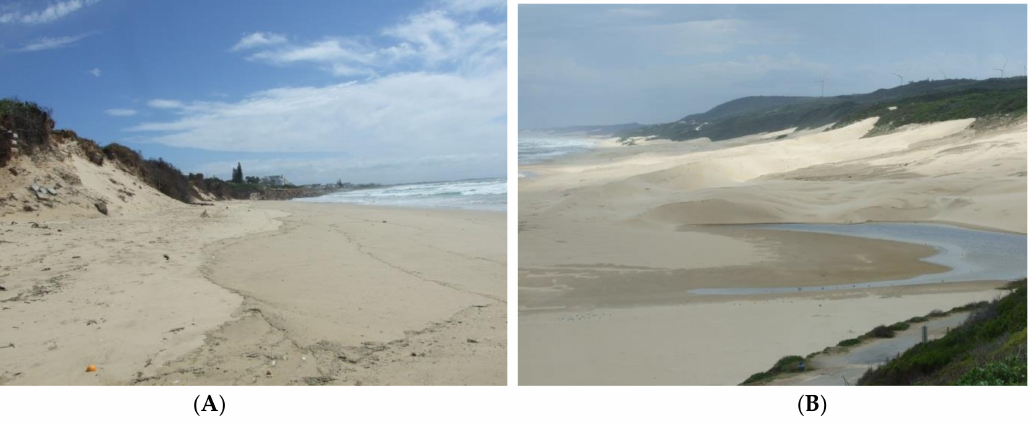
Figure 7. ( A ) St Francis Bay Main Beach that has completely eroded due to inappropriate stabilisation of the dune field that provided the sand supply. Holiday homes are in danger of collapse, as they are positioned just above the eroding dunes shown here (see Lubke 1988). ( B ) Maitland River Mouth where marram grass has never been introduced but any dune pioneers would have little chance of becoming established due to the exposed nature of the undisturbed dunes and the high wind velocities achieved in this area.